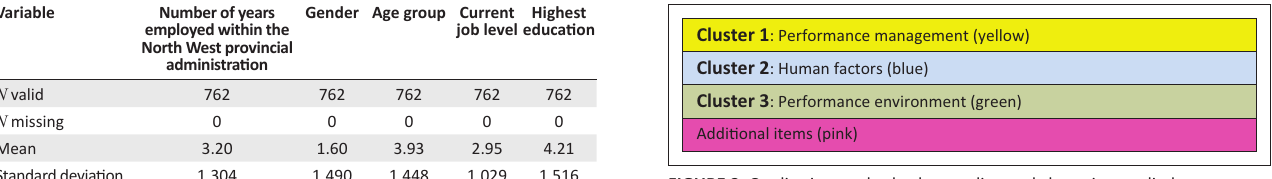
FIGURE 8: Qualitative method colour coding and clustering